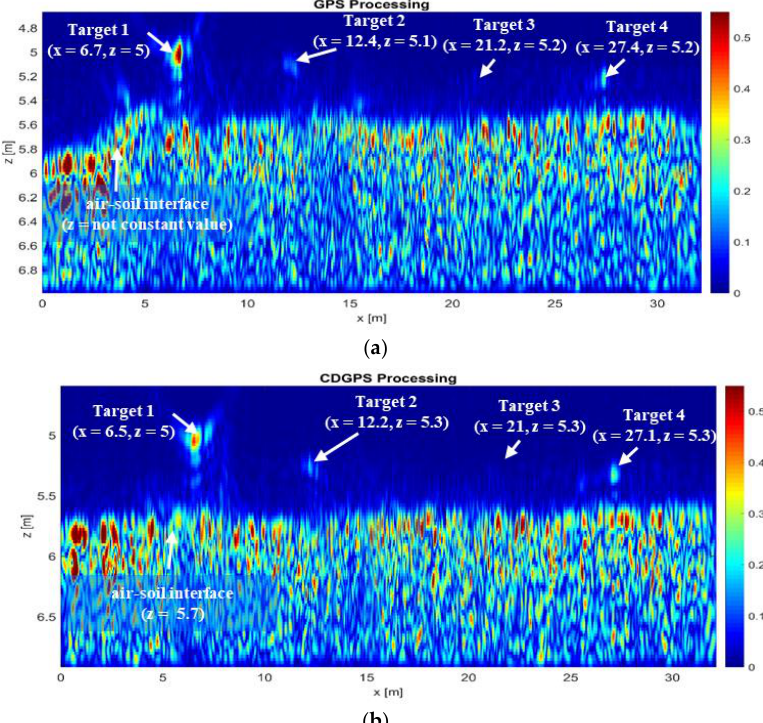
Figure 17. Tomographic images Test 2-Track 2 obtained by Shift and Zoom TSVD algorithm: ( a ) GPS based MoCo; ( b ) CDGPS based MoCo.